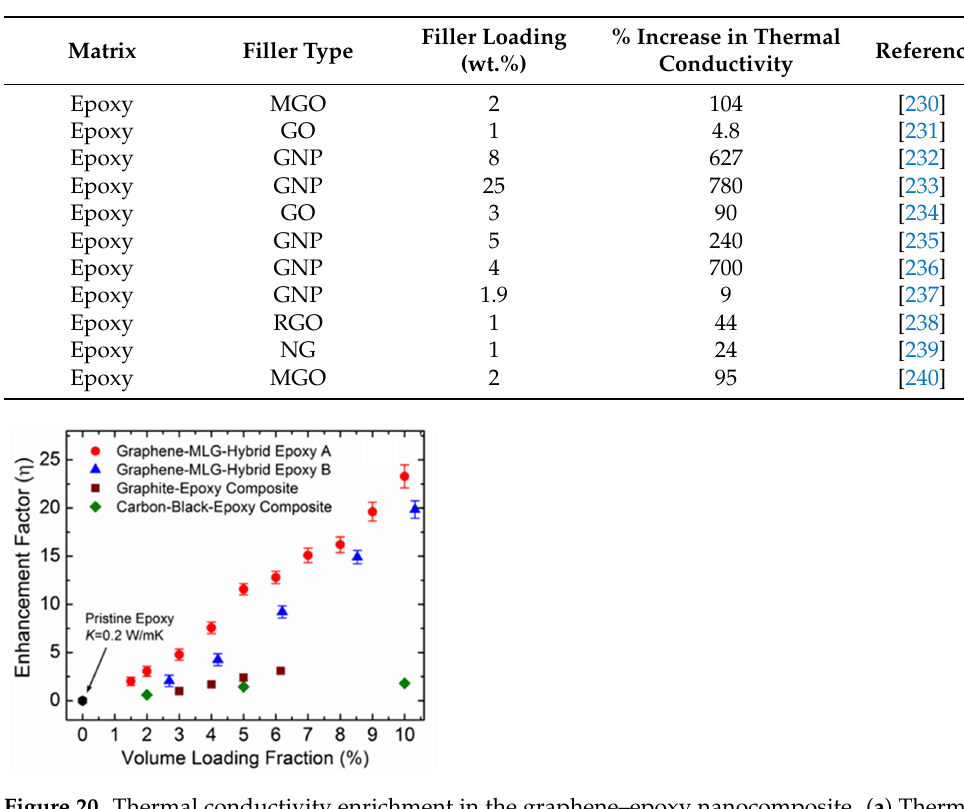
Table 2. Thermal conductivity values of graphene polymer nanocomposites.